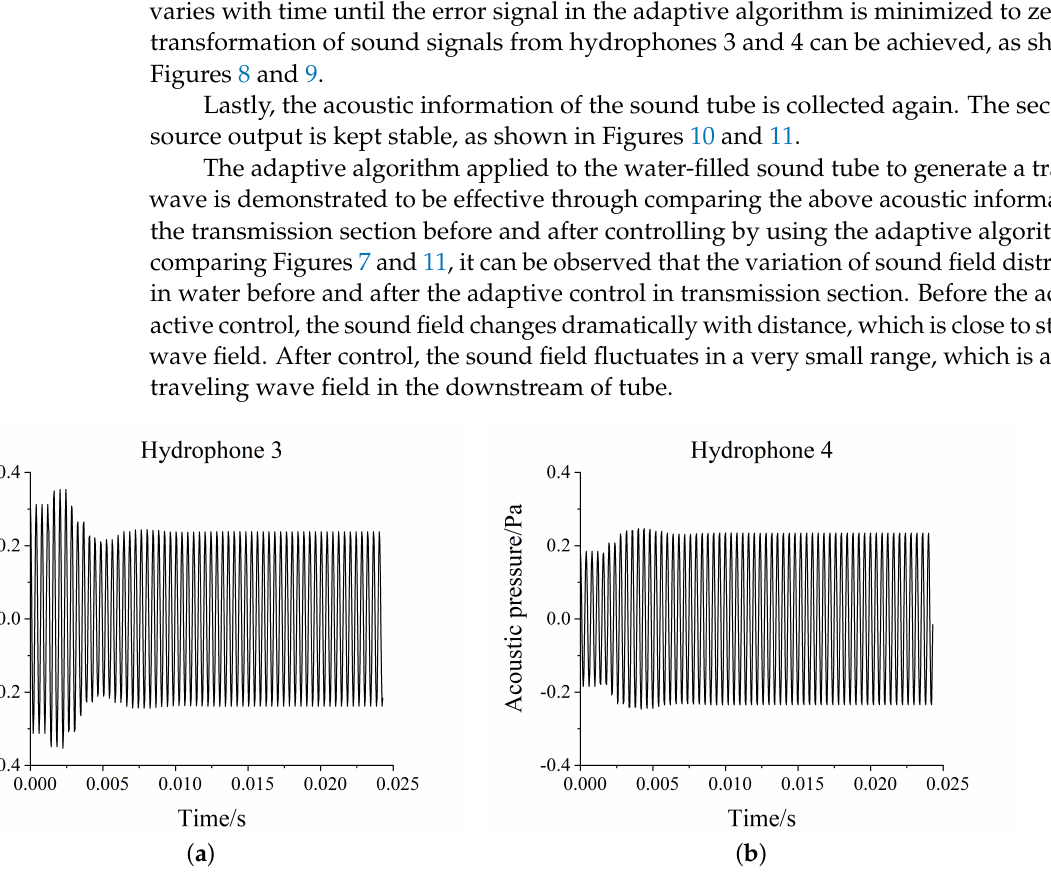
Figure 8. ( a )The signal of hydrophone 3 changes with time in the impedance tube without sample at 2500 Hz. ( b ) The signal of hydrophone 4 changes with time in the impedance tube without sample at 2500